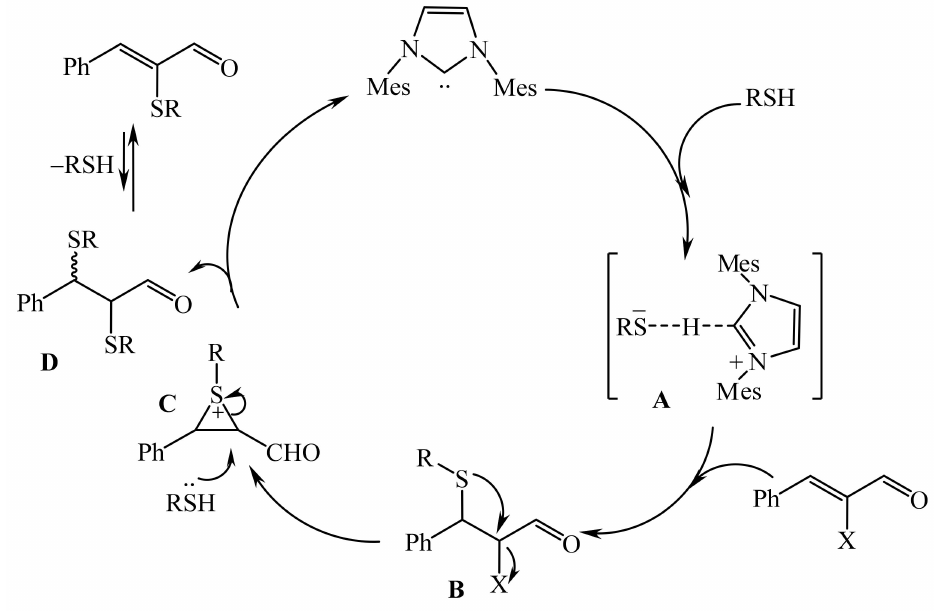
Scheme 17. The proposed mechanism for formation of aldehydes 47 .